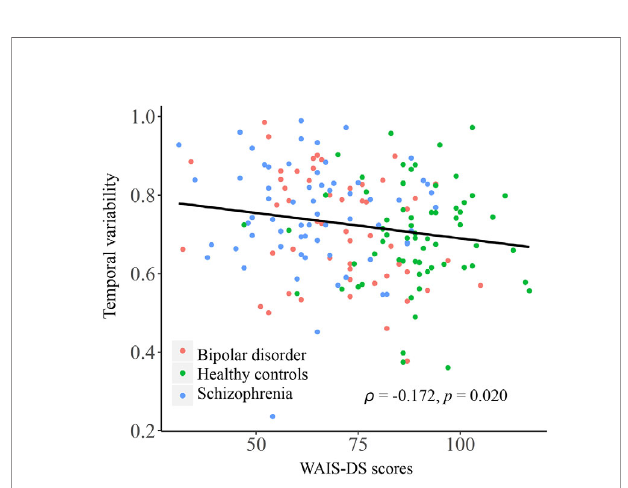
FIGURE 4 | Correlation between the temporal variability of inter-network FC between subcortical and auditory networks and the WAIS-DS scores in the entire sample. The Spearman ’ s correlation coef fi cients ( r ) and p values are presented on fi gures. FC, functional connectivity; WAIS-DS, Digit Symbol Subtest of the Wechsler Adult Intelligence